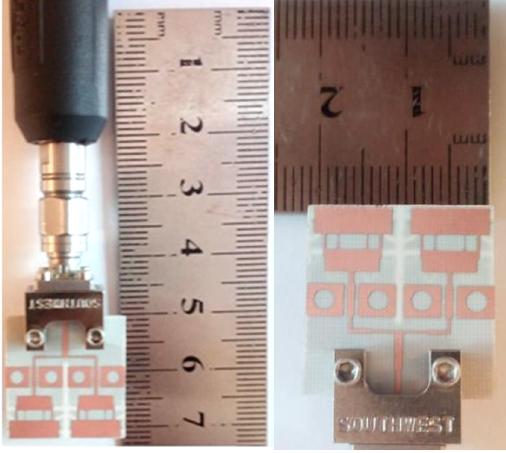
Figure 14. Fabricated model of the proposed mmWave 5G array antenna system.